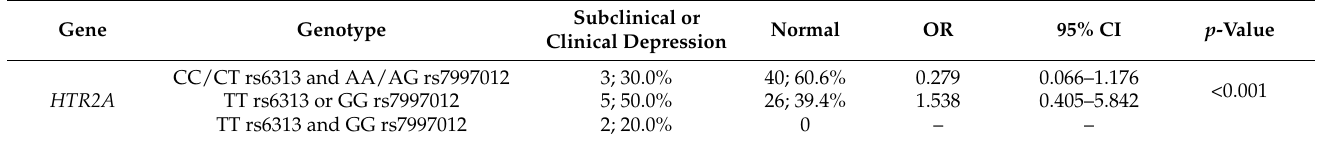
Table 10. Frequencies of recessive alleles of rs6313 and rs7997012 of the HTR2A gene. Odds ratio of subclinical or clinical depression depending on